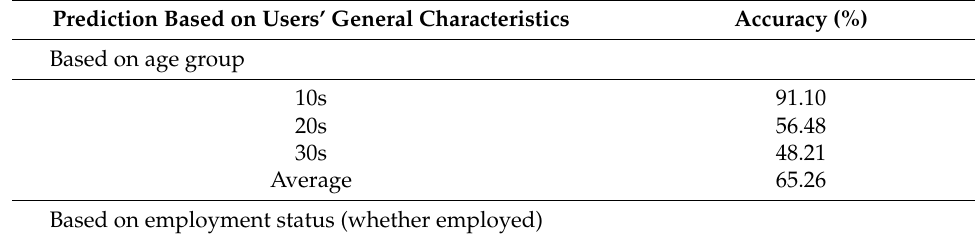
Table 8. Prediction based on Users’ General